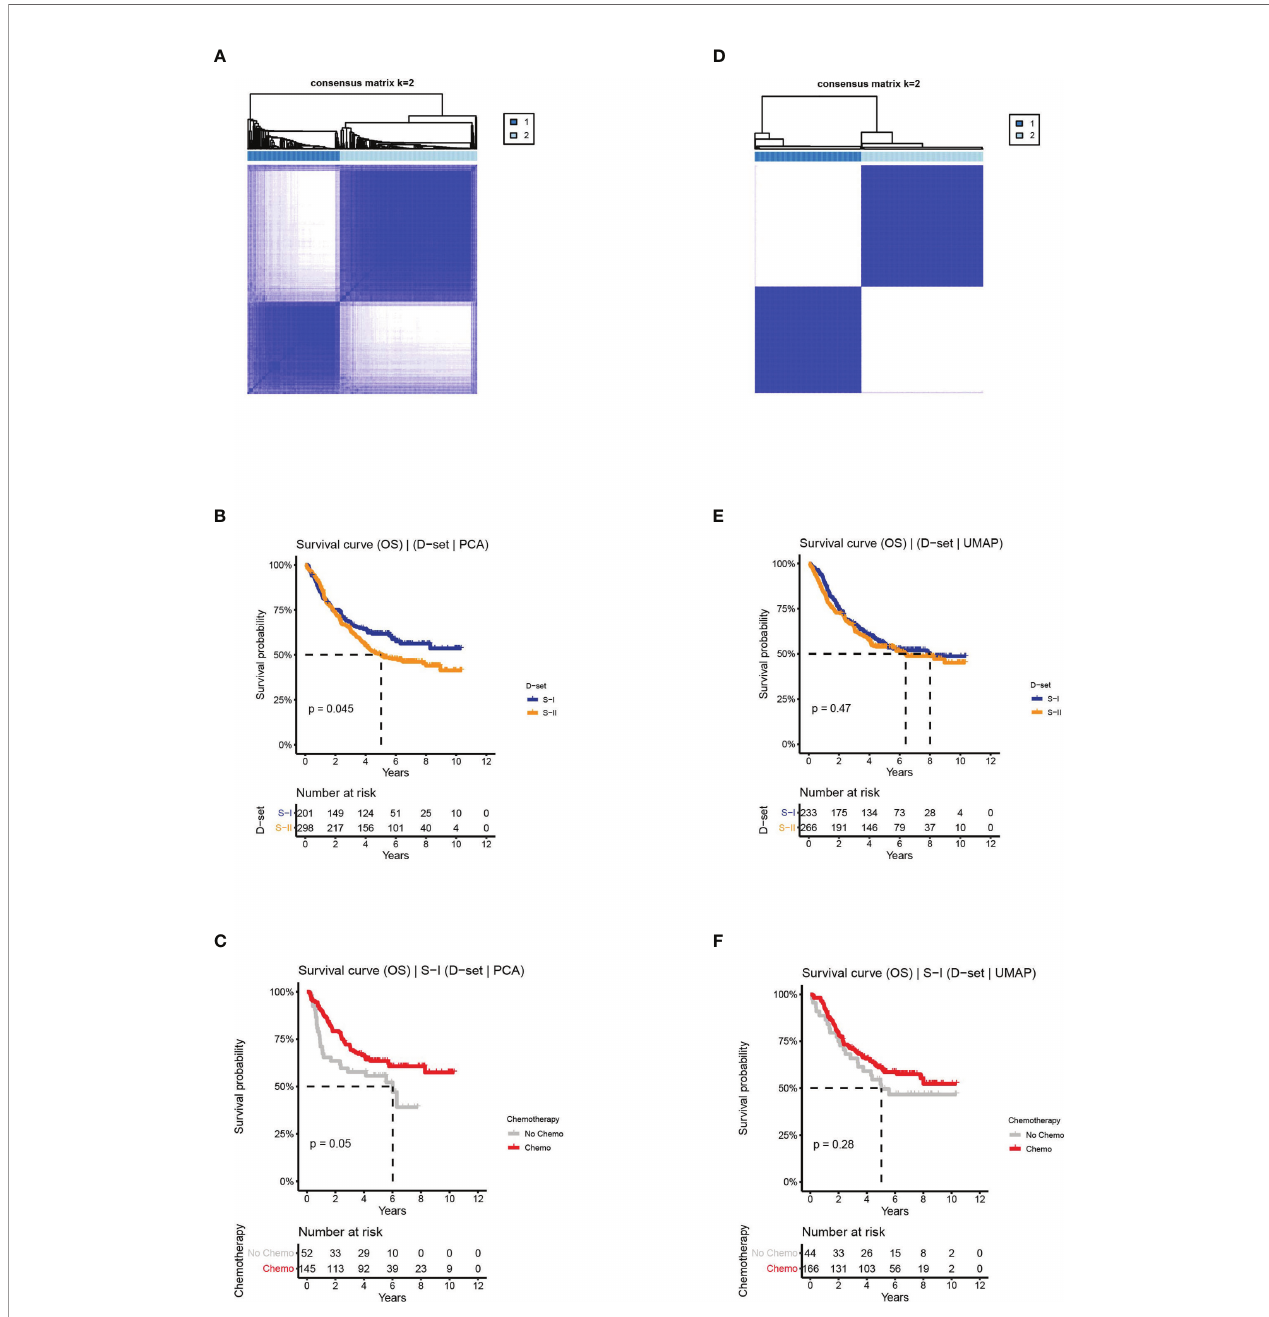
FIGURE 4 | The clinical outcomes of molecular subtypes obtained from two alternative approaches in the discovery set. (A) The clustering results, (B) the OS of S-I and S-II, and (C) the OS by chemotherapy status for S-I, obtained from PCA. (D) The clustering results, (E) the OS of S-I and S-II, and (F) the OS by chemotherapy status for S-I, obtained from